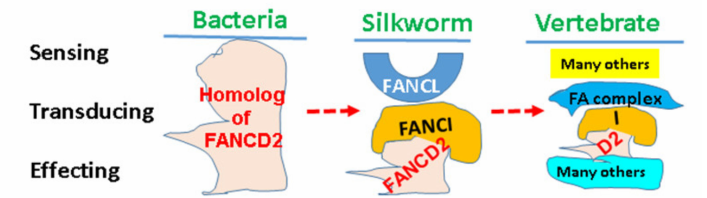
Figure 3. Schematic Outline of a Putative Evolutionary Path for the Focal Point of DDR/FA Signaling across Different Species. In bacteria, the homolog of FANCD2 may act as a sensor, transducer, and/or effector in response to genotoxic stresses. However, it receives a helper of FANCI and a regulator of FANCL in silkworm upon coupling with a variety of insults. FANCL, here, may act relatively more as a sensor. In vertebrate, FANCD2 and FANCI appear to be totally centered, which work in concert with many others to form a very complicated cellular defense signaling